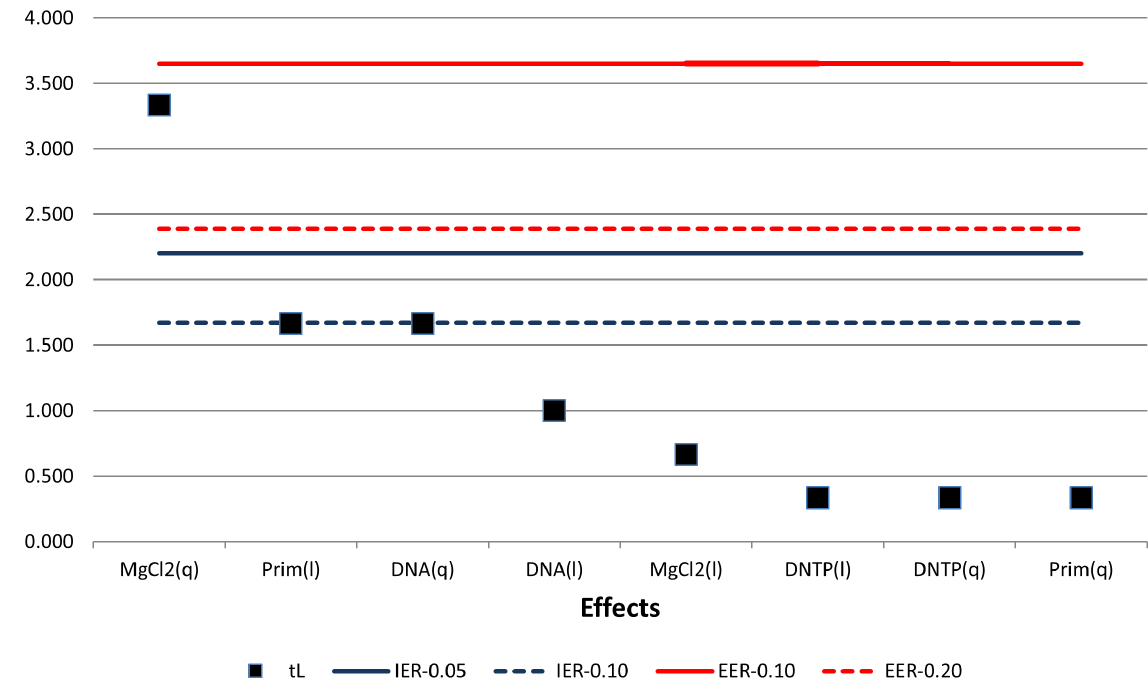
Figure 6. Lenth test profiling results using the corrections of Ye and Hamada [ 47 ] .